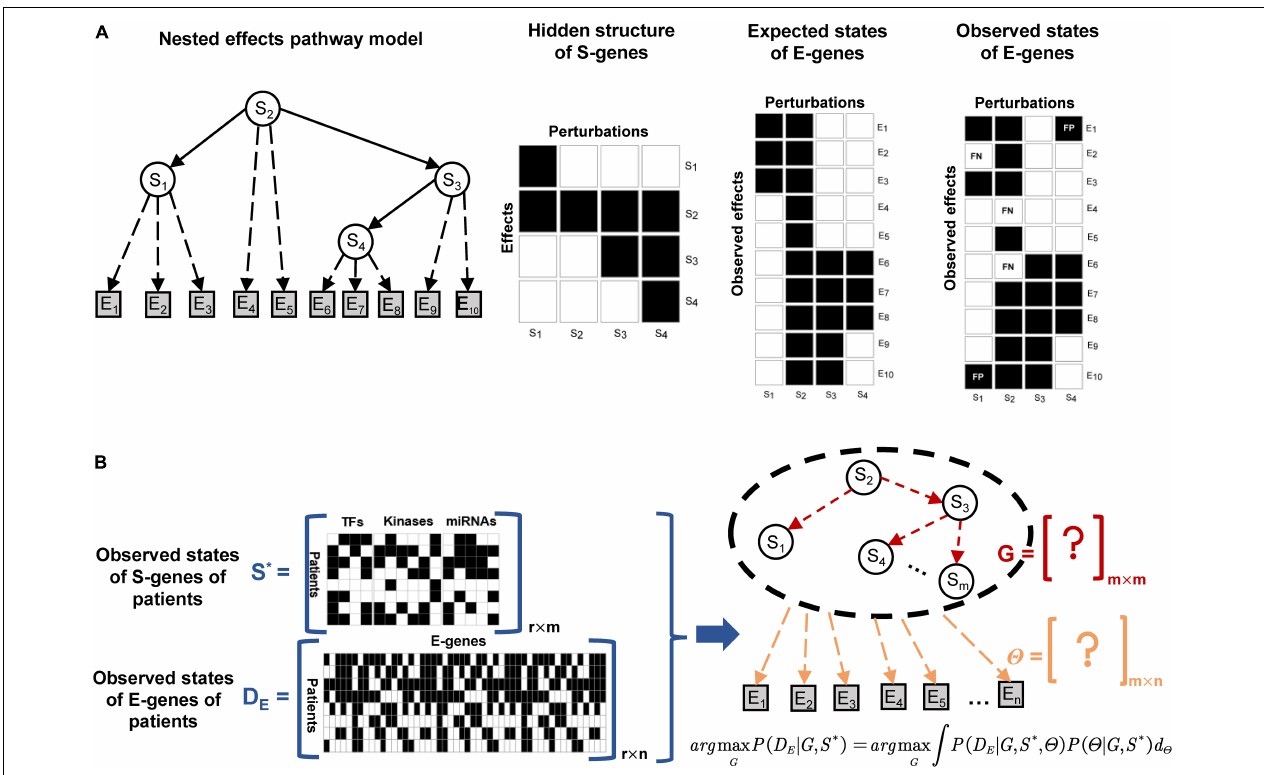
FIGURE 2 | Illustration of the nested effects model and NEM-Tar for real cancer samples. (A) The S-genes are modeled as hidden variables, and their signaling interaction graph G (solid arrows) is the target to infer. In experiments with perturbations to individual S-genes, differential expression of downstream genes could be observed and considered as effect reporter genes (E-genes). Assuming that each E-gene is directly regulated by at most one S-gene in G , the maximum a posteriori attachment (cid:50) (dashed arrows) of effect genes to S-genes could be computed. The goal is to search for the signaling graph G , which yields the most likely probabilistic nested effects. (B) For an extra observational dimension (the real patients), the necessary adjustment should be conducted on the design and inference strategies of classic NEM. However, the information that needs to be inferred is also the hidden interaction between S-genes and the attachment relationship of E-genes to